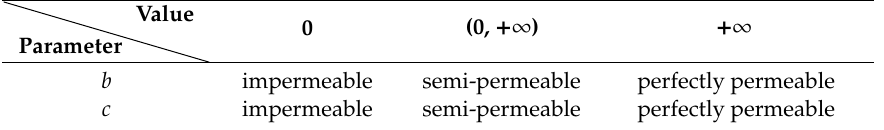
Table 1. Description of parameters b (top surface) and c (bottom